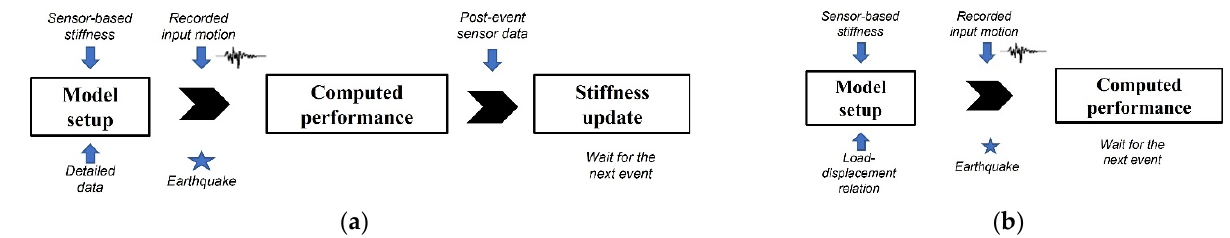
Figure 5. Flowcharts to be followed for ( a ) complete modelling and ( b ) simplified